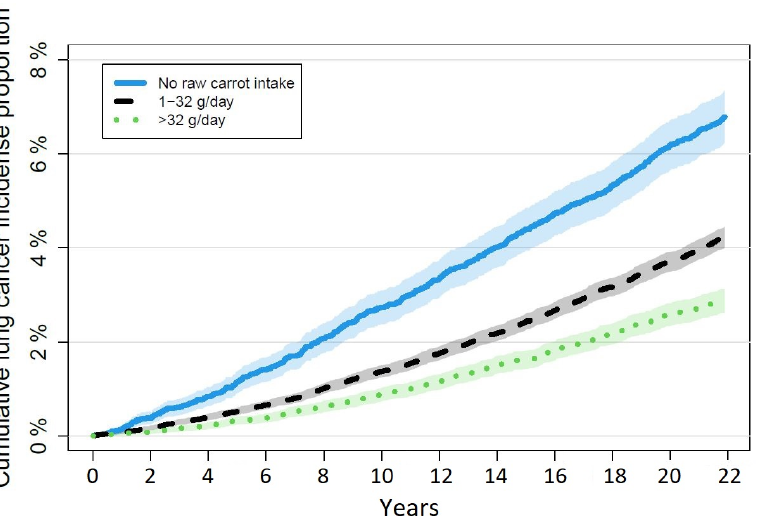
Figure 3. Cumulative incidence proportions of lung cancer during follow-up stratified by raw carrot intake. n = 55,765.